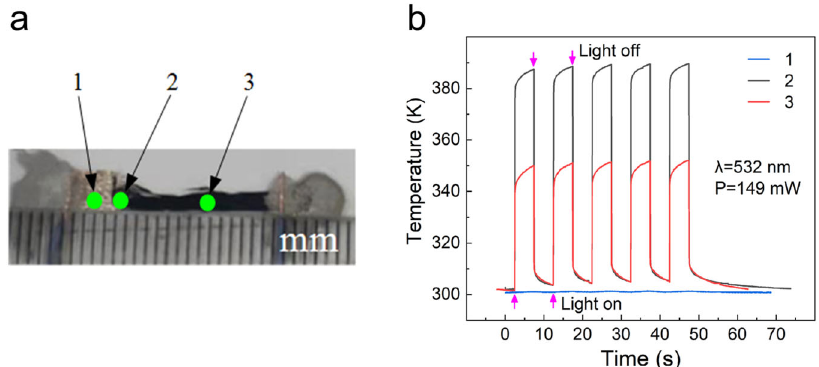
Fig. 4 Comparison of the photothermal conversion ability of the AgNSF, AgNSF/CNTF heterojunction, and CNTF. AgNSF (test point 1), AgNSF/CNTF heterojunction (test point 2), and CNTF (test point 3) of the sample irradiated by a laser with wavelength of 532 nm, power of 149.0 mW, and spot